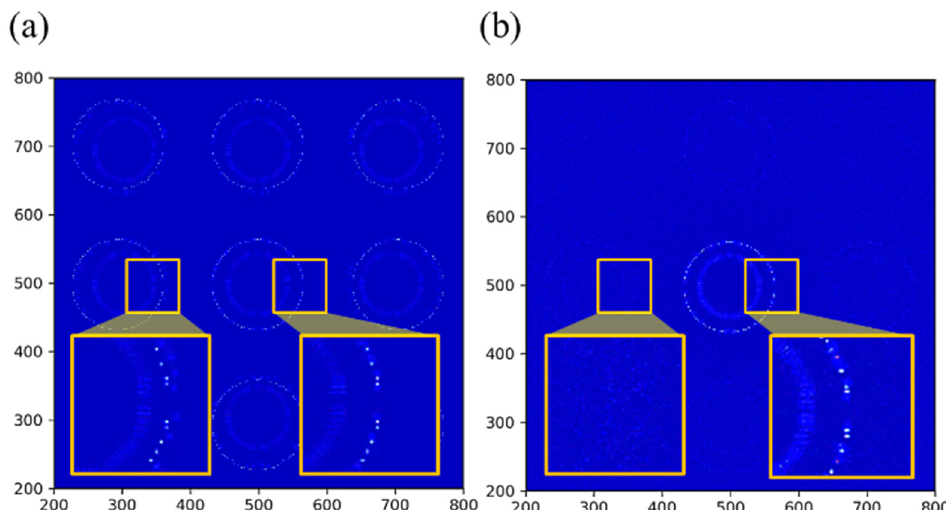
Figure 4. Numerical simulation of a point cloud hologram with ( a ) conventional periodic pixels and ( b ) fully non-periodic pixels.